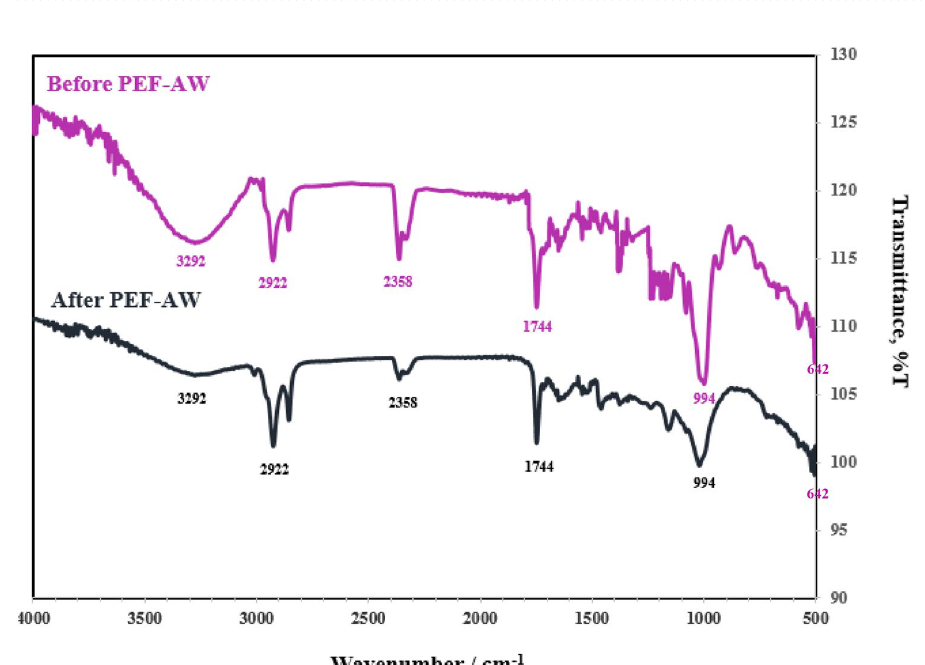
Figure 6. FTIR spectra of rice bran of BRG before and after extraction by